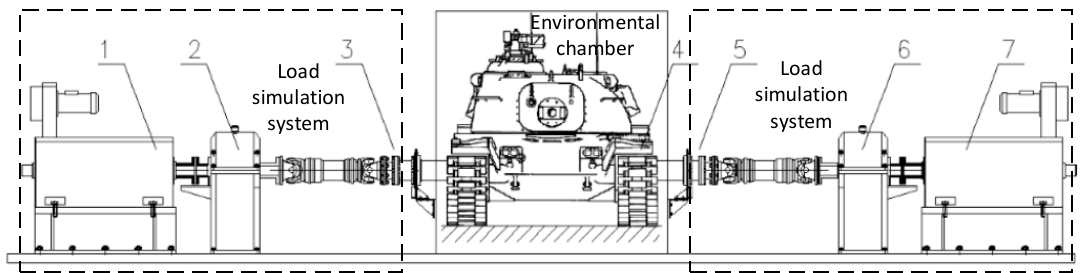
Figure 1. Simulation test bench for tracked vehicles.